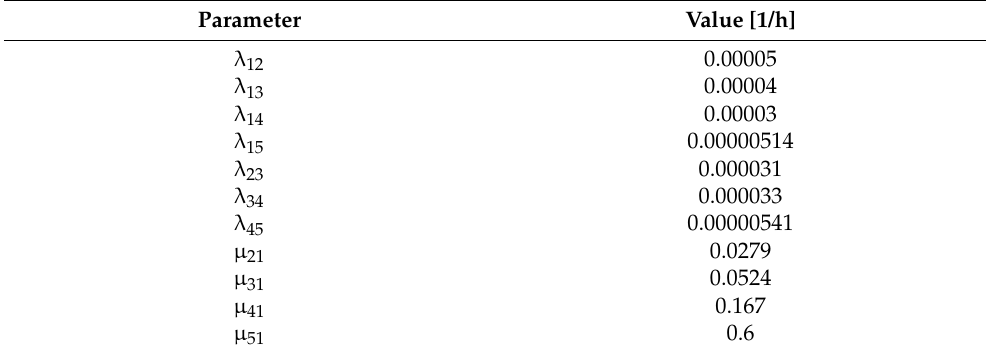
Table 1. System reliability parameters.